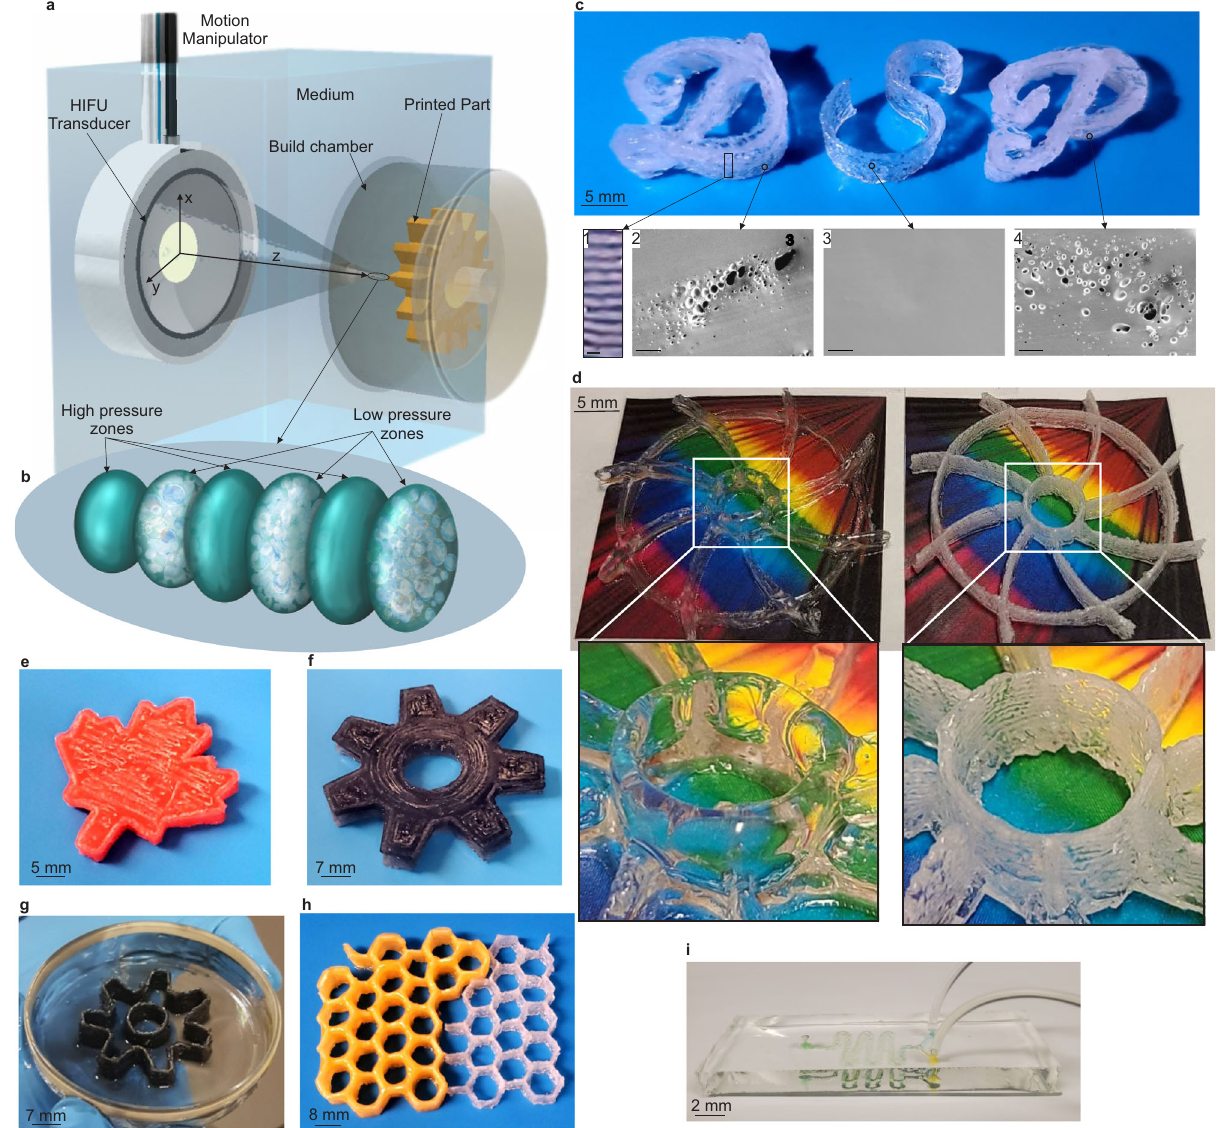
Fig. 1 DSP concept and printed parts. a DSP process schematic. b Detailed view of UAMR, bubbles are created in low-pressure zones. c Printed “ DSP ” letters. c1 porous/transparent structure of the printed part (the scale bar is 200 μ m). c2 – 4 , SEM pictures of the microstructure of the printed parts (the scale bar is 100 μ m). d Printed impellers, transparent and porous. e – h Printed maple leaf, gear, shell and honey comb, respectively. i Molded micro fl uidic channel using 3D printed PDMS mold. (HIFU: high-intensity